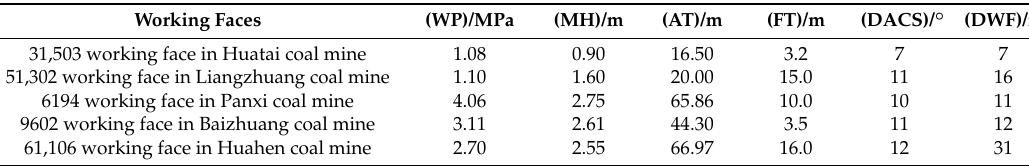
Table 3. Prediction results of the five tested working faces.